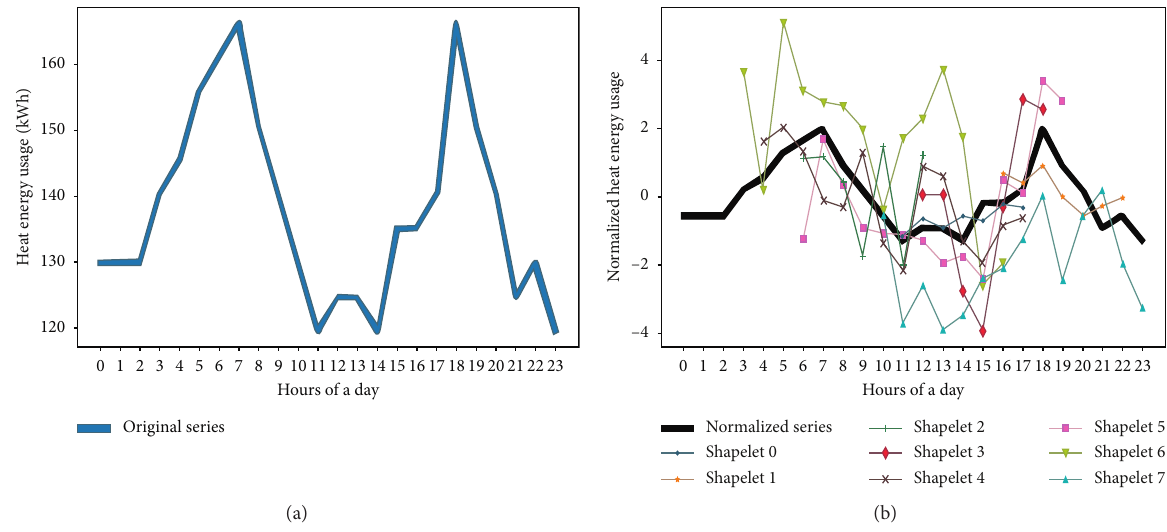
Figure 5: Sample case four (nonnight setback, multifamily hot water profile): morning peak at 7 a.m. and evening dip at 6